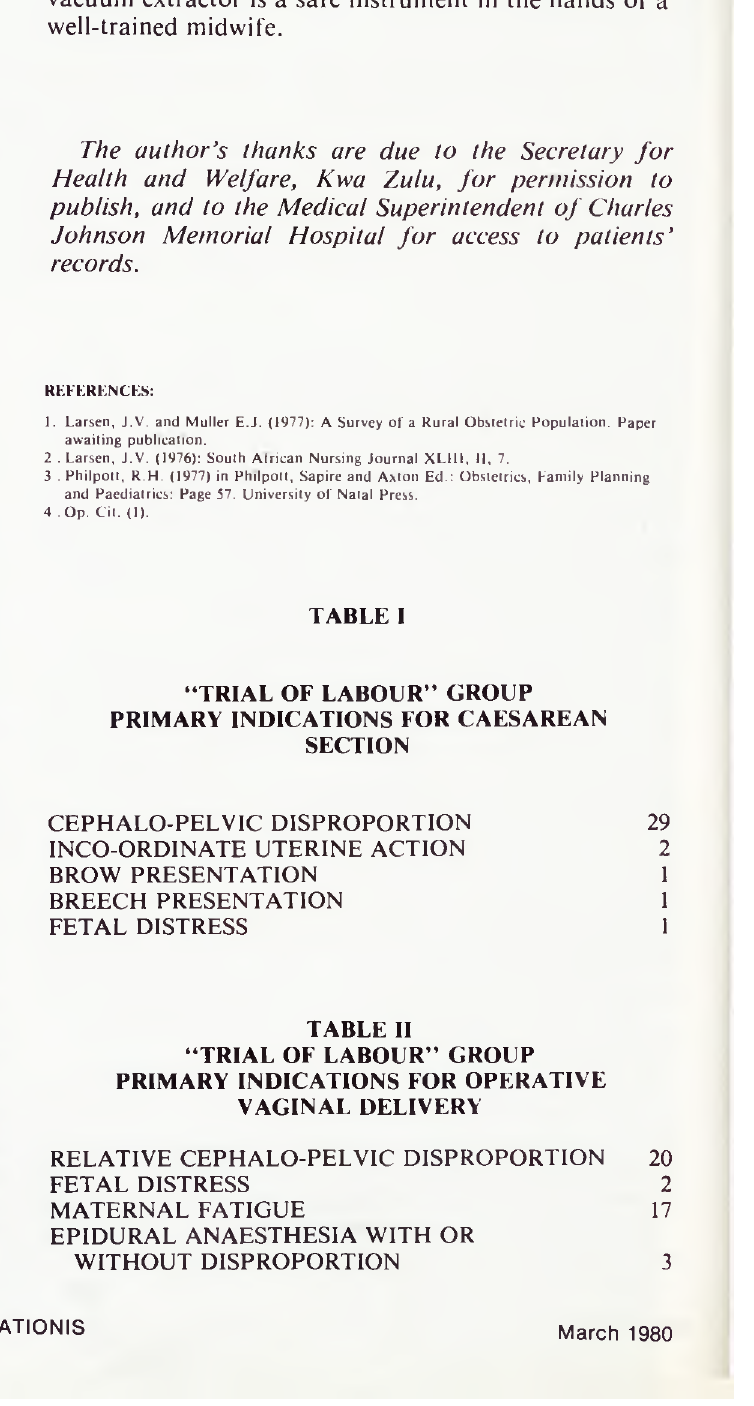
“TRIAL OF LABOUR” GROUP PRIMARY INDICATIONS FOR